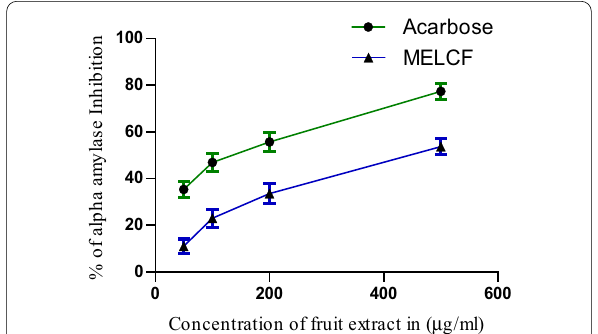
Fig. 1 In vitro alpha amylase inhibitory activity of acarbose and MELCF. The values are represented as an average of triplicate trials, the error bars are SEM